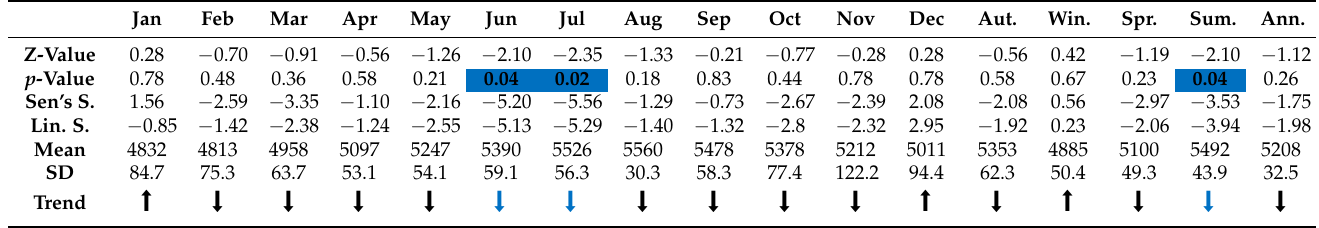
Numbers in bold and blue: significance level, p -value < 0.05. Table A1. Monthly RSLE, Sen’s slope, and MK tests for the entire Ladakh.